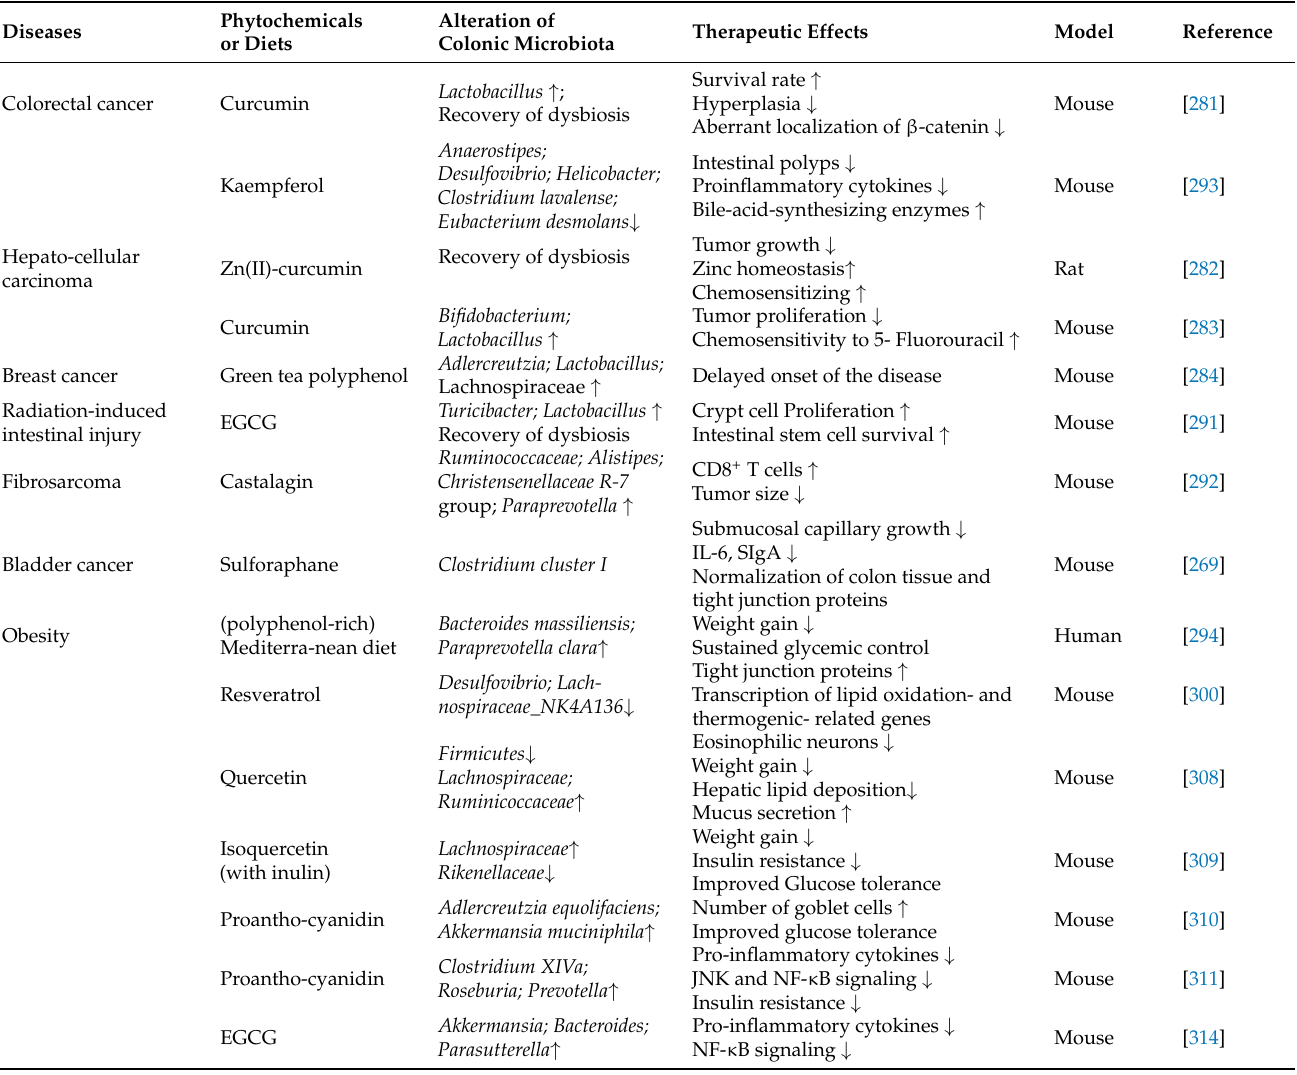
Table 2. Modulation of colonic microbiota by phytochemicals and their effects on